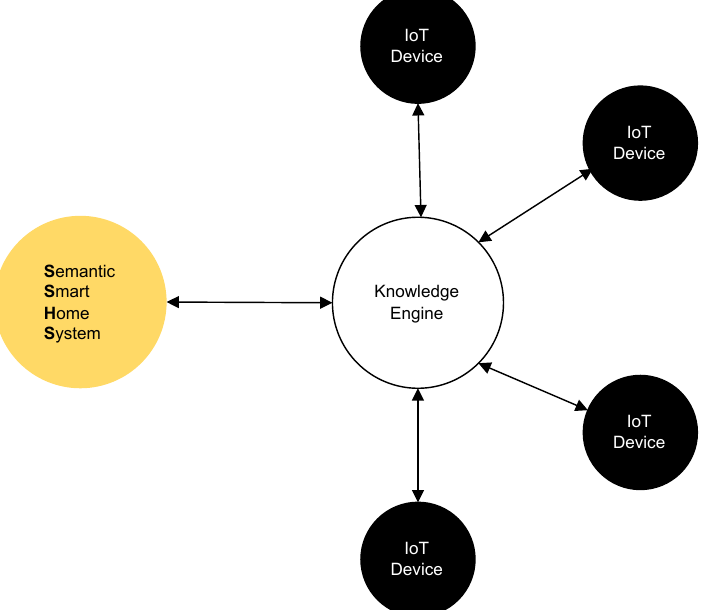
Figure 1. The schema depicts an example of SAREF environment setup, as intended in this study, composed of four IoT devices that exchange data in RDF format, through the knowledge engine, with the Semantic Smart Home